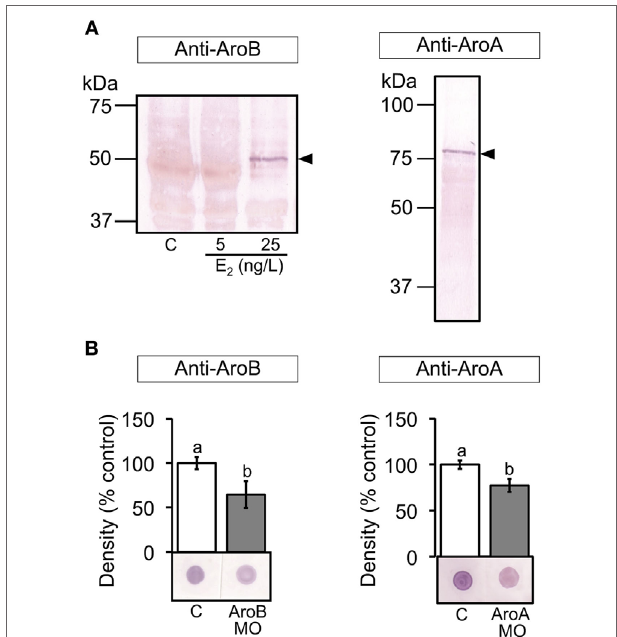
FigUre 3 | Validation of MO-mediated knockdown on translation. (a) Western blots of brain extracts from control and E 2 exposed fish and ovarian extract from untreated fish were stained with the antiserum to AroB and AroA, respectively, showing a positive band at the expected size for each aromatase as indicated by arrowheads. (B) Dot blots of 6 and 2 dpf larval extracts using the antiserum to AroB and AroA, respectively, were analyzed. Representative blots are shown in each graph. Data are presented as a mean ± SEM. Different letters in each graph indicate significant differences ( p <